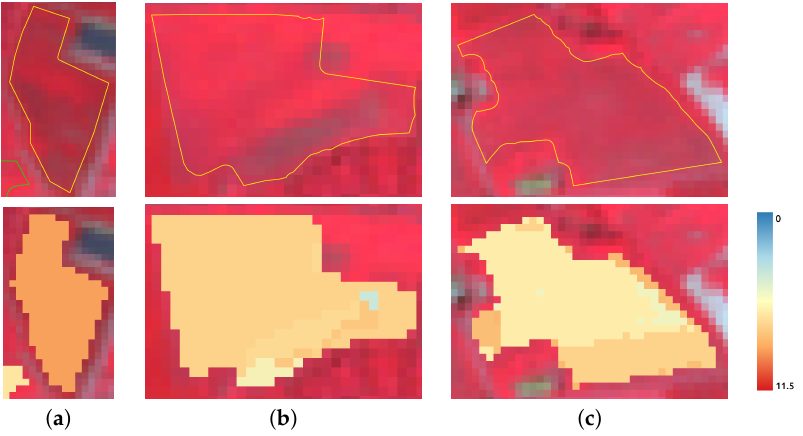
Figure 12. Maps of spectral heterogeneity inside three grasslands ( a – c ). The first row shows the grasslands’ polygon limits in yellow on the SPOT5 false color image acquired on 10 May 2015. The second row shows the clusters after an HDDC clustering into eight clusters using multitemporal data. The color scale corresponds to the log-transformed variability of each cluster c in the grassland g i . ( a ) H = 0.10, E = 0, V = 10.13, W = 10.13, B = 0; ( b ) H = 1.57, E = 0.68, V = 10.06, W = 9.41, B = 9.33; ( c ) H = 2.89, E = 1.06, V = 9.58, W = 9.22, B = 8.42. The floristic record of these three grasslands can be found in the Appendix A, Table